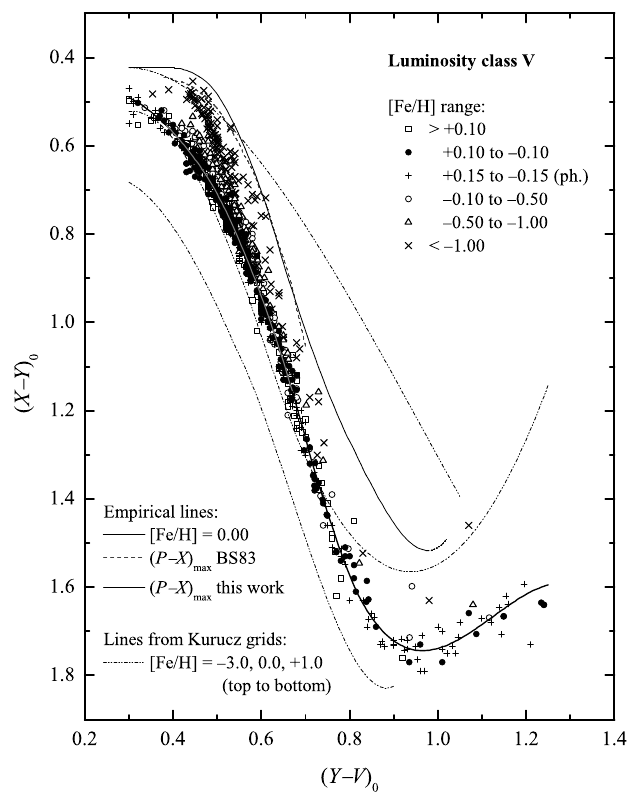
Fig. 4c. X – Y vs. Y – V diagram for dwarf stars. Symbols and lines the same as in Figs. 4 a,b. for P – X and X – Y to (cid:6) 0 : 03 for P – Y . For Y – V > 0 : 75 (spectral types